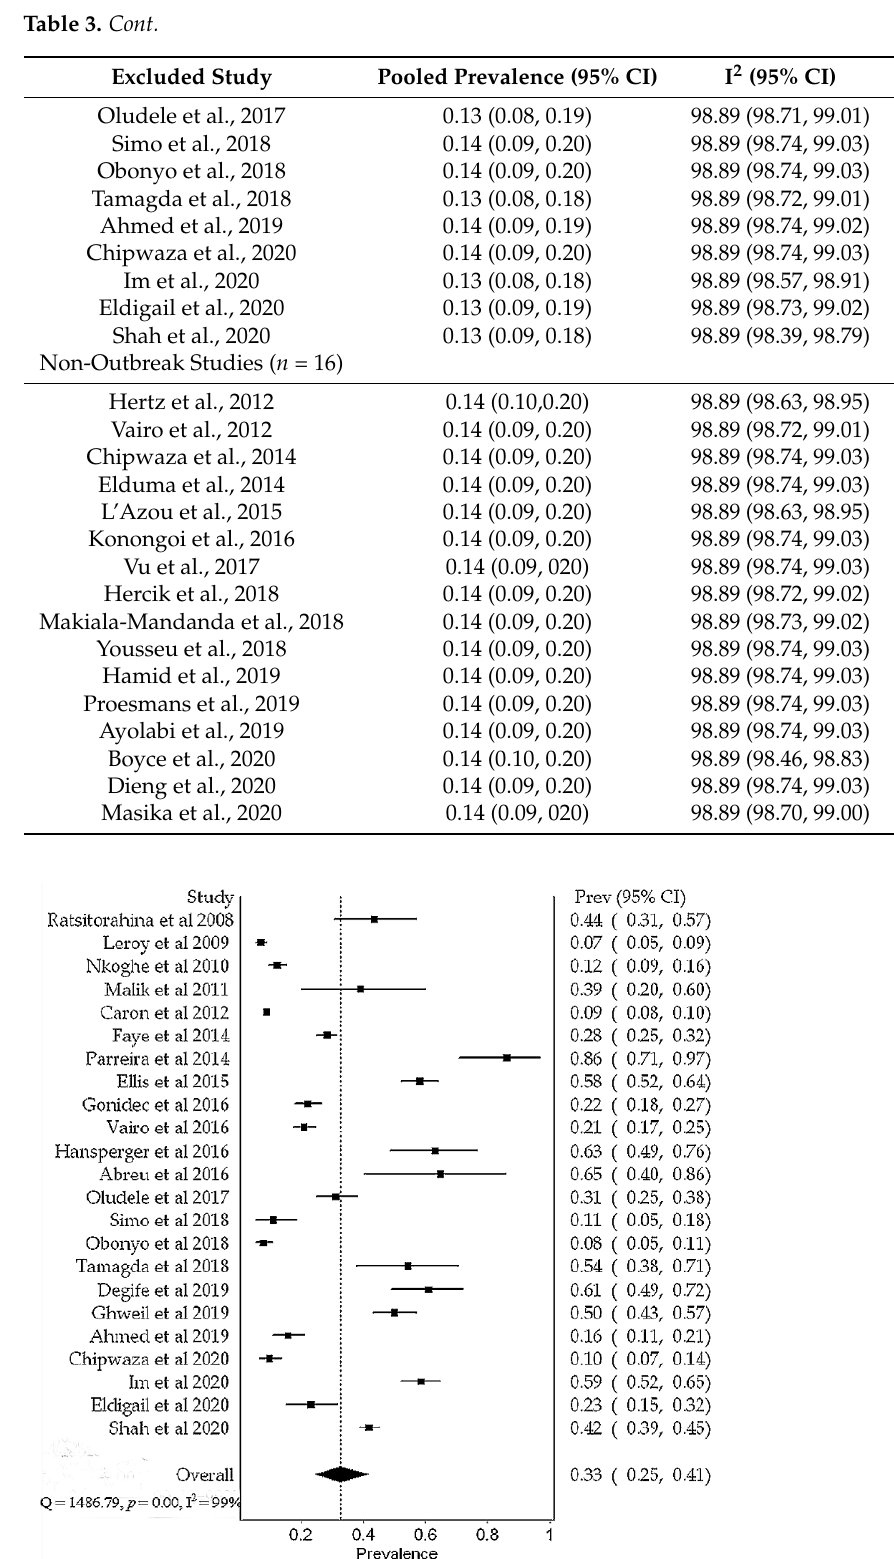
Figure 5. A meta-analysis of dengue virus prevalence in febrile patients during the non-outbreak periods.